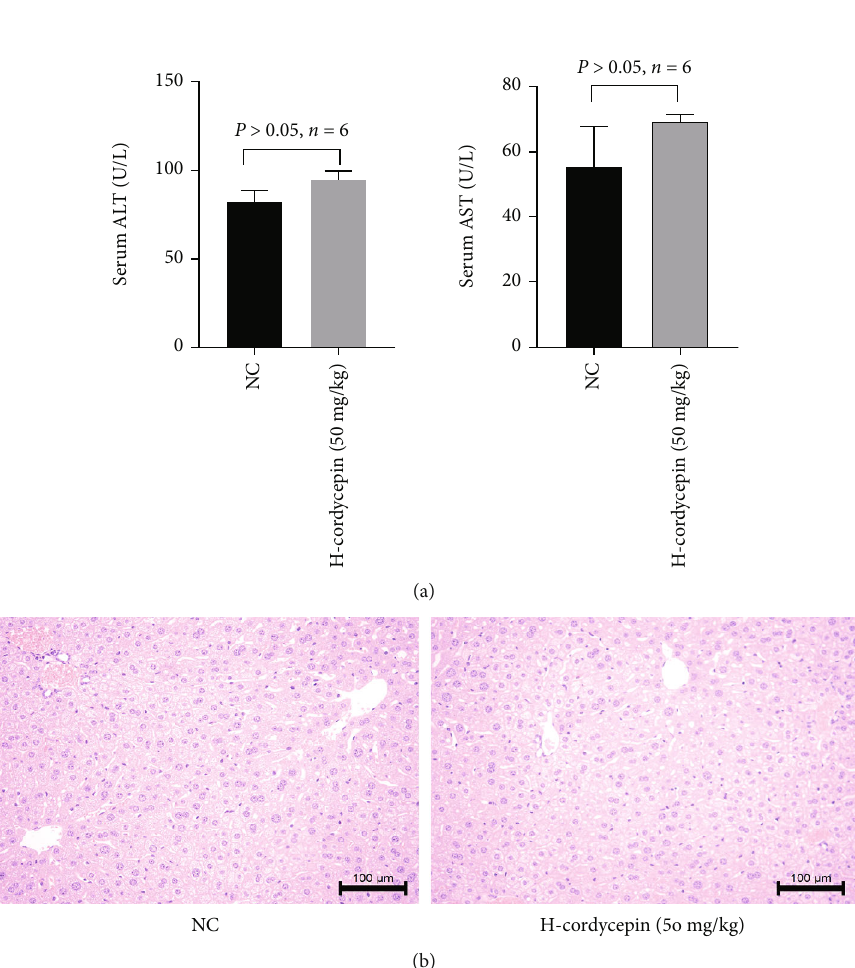
Figure 1: Cordycepin had no side e ff ects on liver structure and function. Note: (a) the levels of ALT and AST were shown as mean ± SD ( n = 6 ; p > 0 : 05 ). It indicated that there was no signi fi cant di ff erence among the two groups. (b) Representative H&E-stained hepatic sections were examined under light microscopy and imaged at a × 200 magni fi